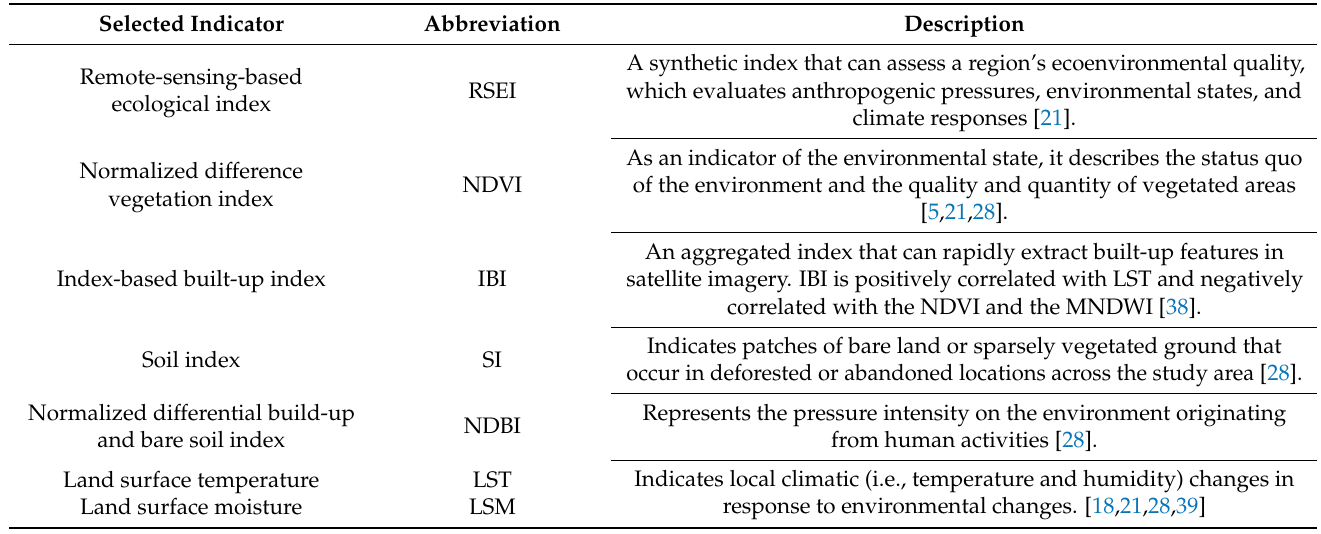
Table 1. Summary of abbreviations for all selected